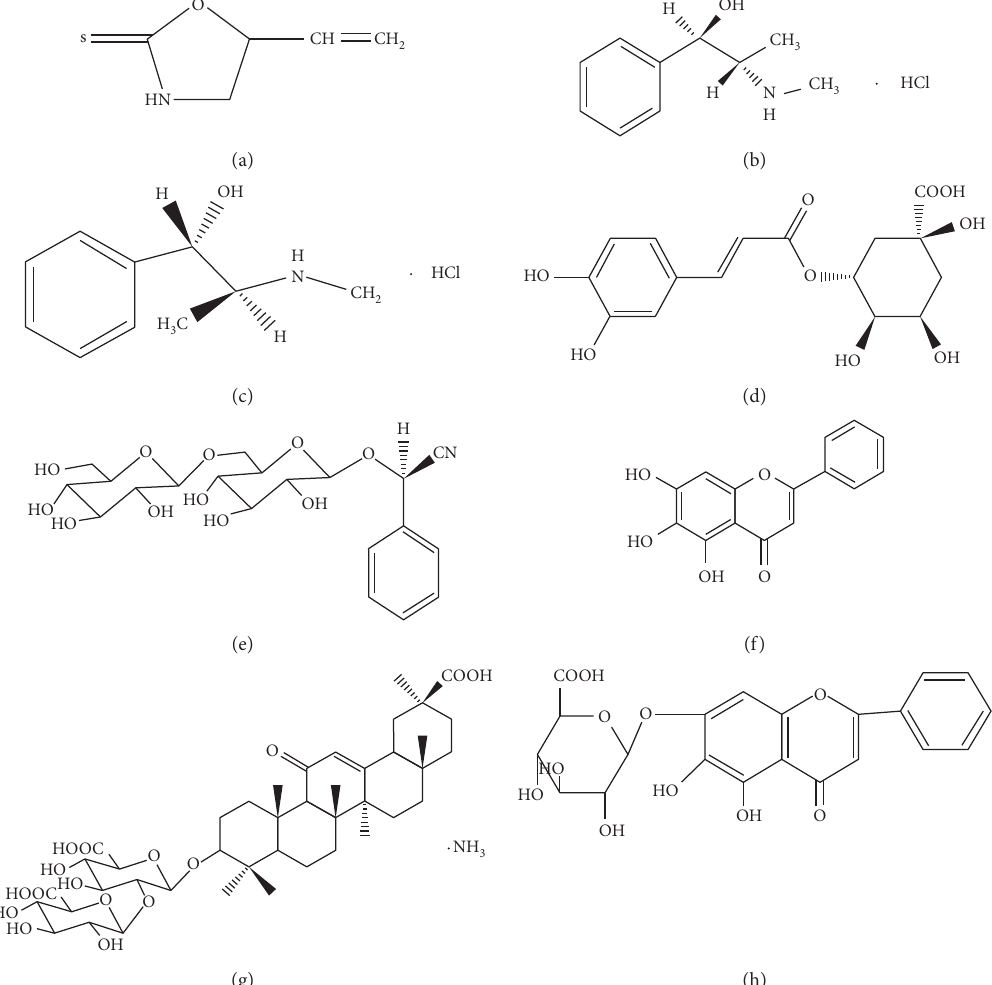
Figure 1: The chemical structures of the investigated compounds: (a) (R, S)-goitrin, (b) ephedrine hydrochloride, (c) pseudoephedrine hydrochloride, (d) chlorogenic acid, (e) amygdalin, (f) baicalein, (g) ammonium glycyrrhizinate, and (h)